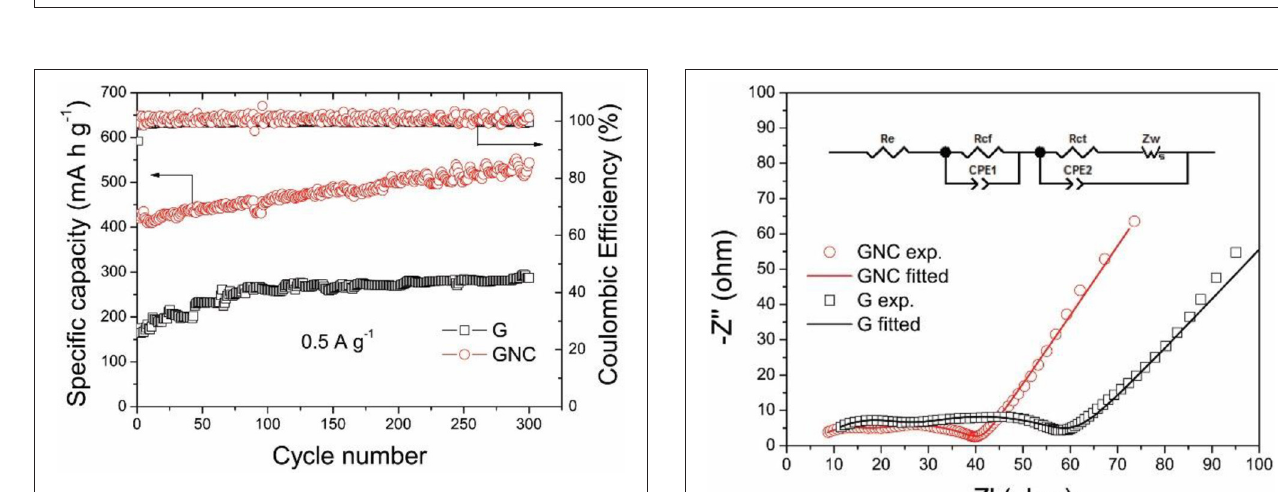
The electrochemical impedance spectra (EIS) of the G//Li and GNC//Li half cells after the cycling tests were measured at the discharged state (about 0.01 V). The Nyquist plots and the equivalent circuit used for the data fitting are shown in Figure 6 . Both Nyquist plots show two compressed semicircles in the high and middle-frequency regions, which correspond to the resistance of Li + ions penetration through the SEI film ( R cf